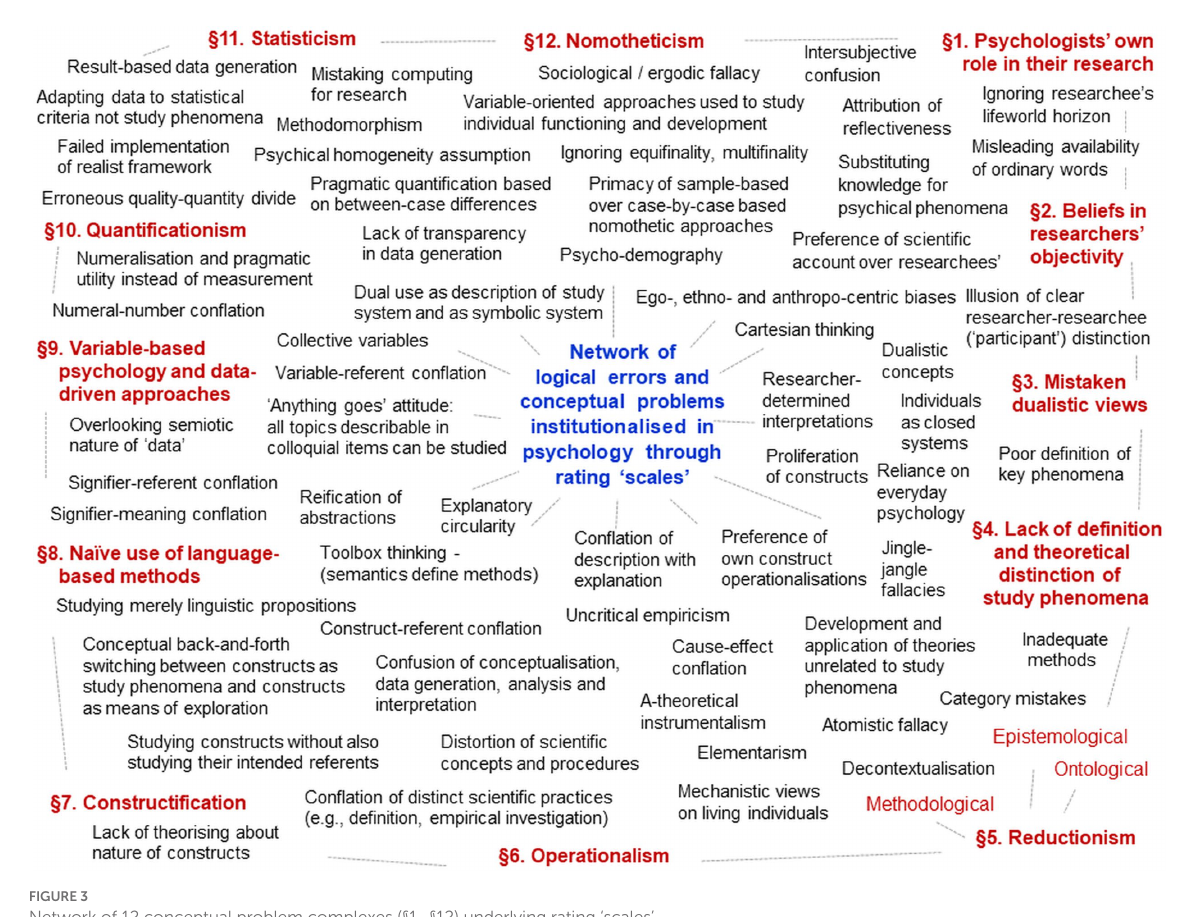
FIGURE 3 Network of 12 conceptual problem complexes (§1–§12) underlying rating